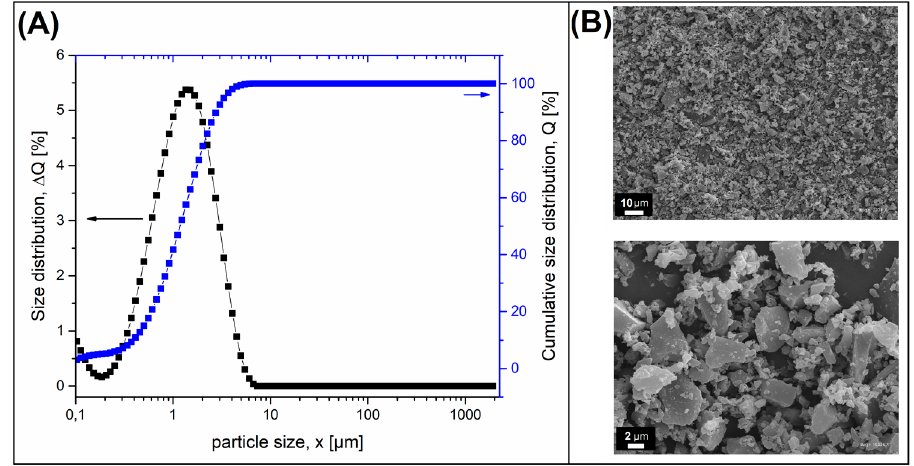
Figure 1. ( A ) Size distribution histograms and ( B ) SEM microphotograph of biochar (BioC) particles.